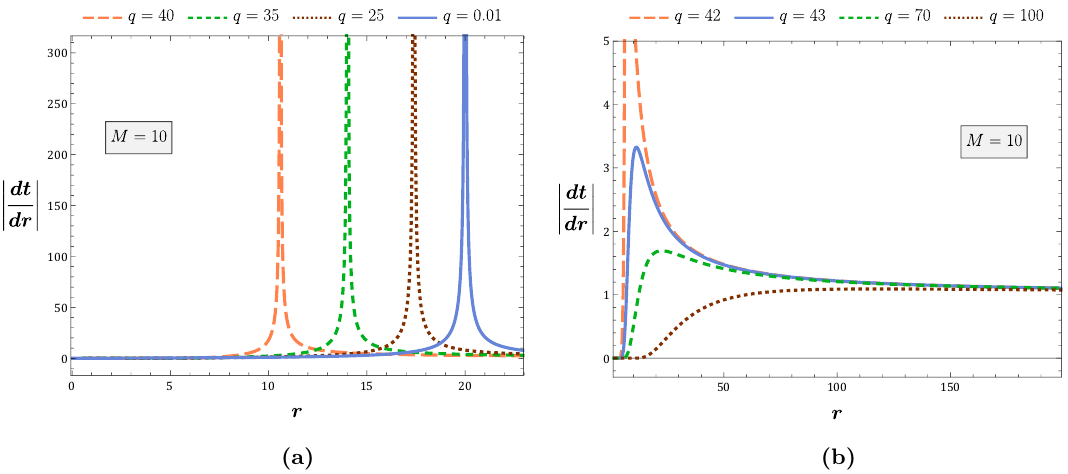
Figure 1. Both (a) and (b) depict graphs of the ratio | dt/dr | in terms of the radial coordinate r for various values of the parameter q while keeping the mass parameter constant, i.e. M = 10 . In (a) q = 40 , 35 , 25 , 0 . 01 from left to right, while in (b) q = 42 , 43 , 70 , 100 from top to